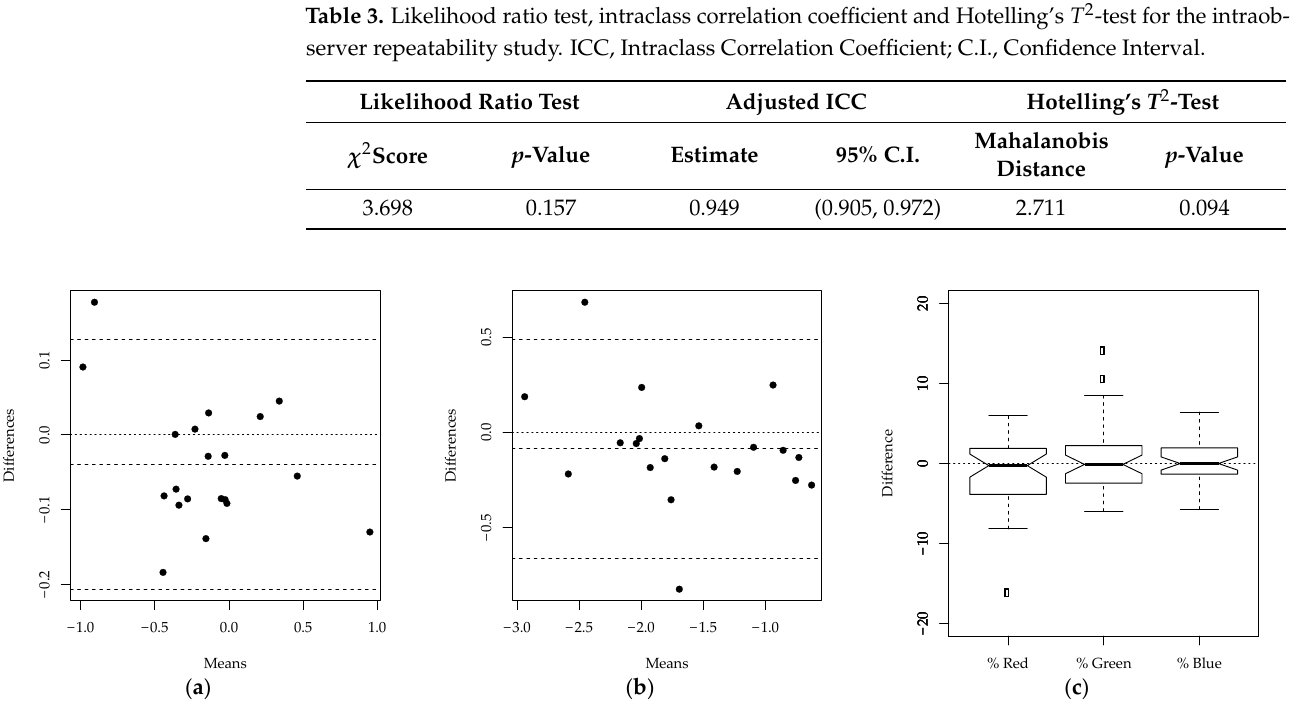
Table 4. Likelihood ratio test and intraclass correlation coefficient for the interobserver reproduci- bility study. ICC, Intraclass Correlation Coefficient; C.I., Confidence Interval.